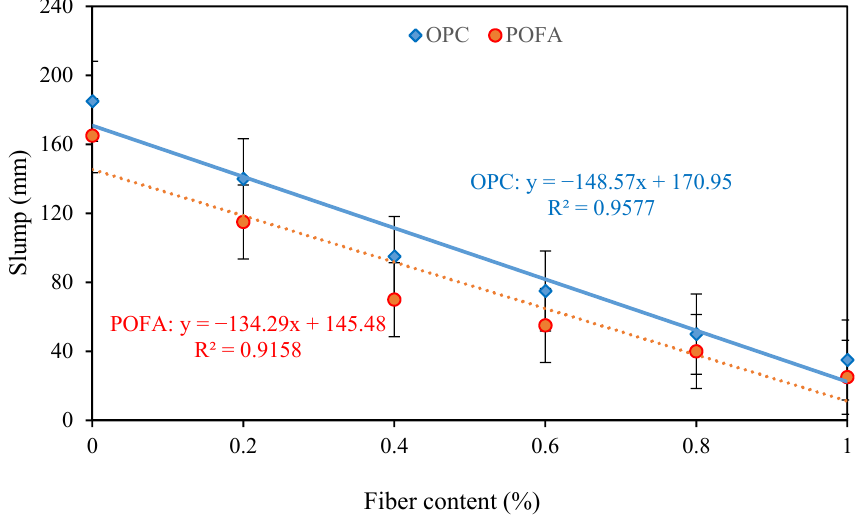
Figure 2. Effects of the WPFT fibers at various dosages on the slump of fresh concrete mixtures. Crystals 2021 , 11 , x FOR PEER REVIEW